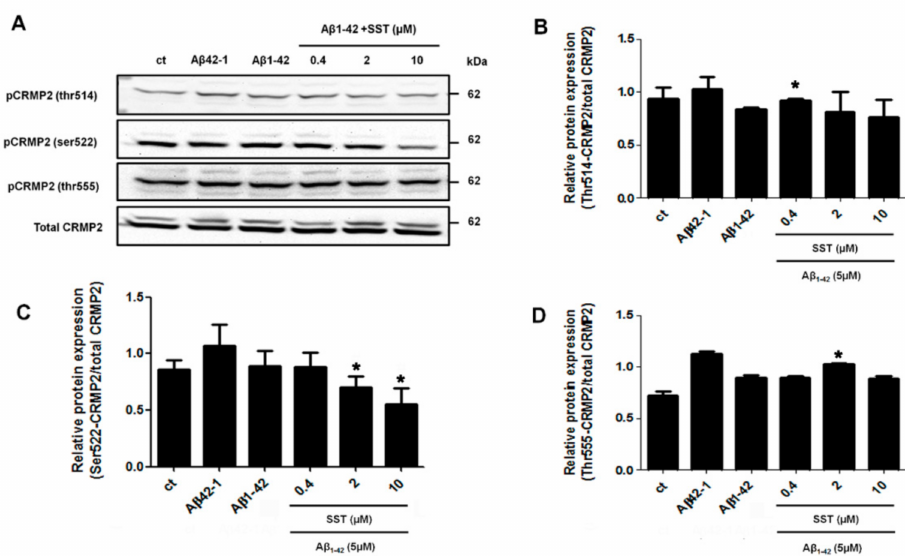
Figure 3. SST-mediated regulation of CRMP2 (Ser522) phosphorylation. ( A ). Representative Western blot showing the decreased phosphorylation level of Ser522-CRMP2 with increasing concentration of SST. Total CRMP2 was used as a loading control. B-D. Graphs represent the densitometry analysis of Western blot data shown in A for Thr514-CRMP2 ( B ), Ser522-CRMP2 ( C ), and Thr555-CRMP2 ( D ). Note that the Ser522-phosphorylation level is inhibited in a dose-dependent manner with increasing concentration of SST in the presence of A β . The data represent the mean ± SD of three independent experiments. * p < 0.05 against A β 1-42 treated